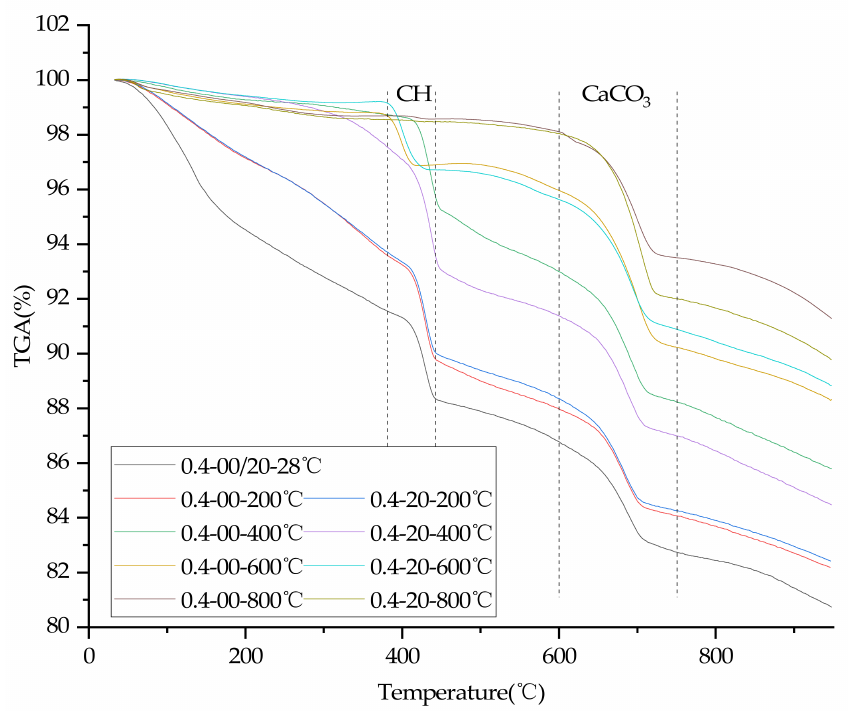
Figure 9. TGA test results of concrete specimens (water/cement ratio of